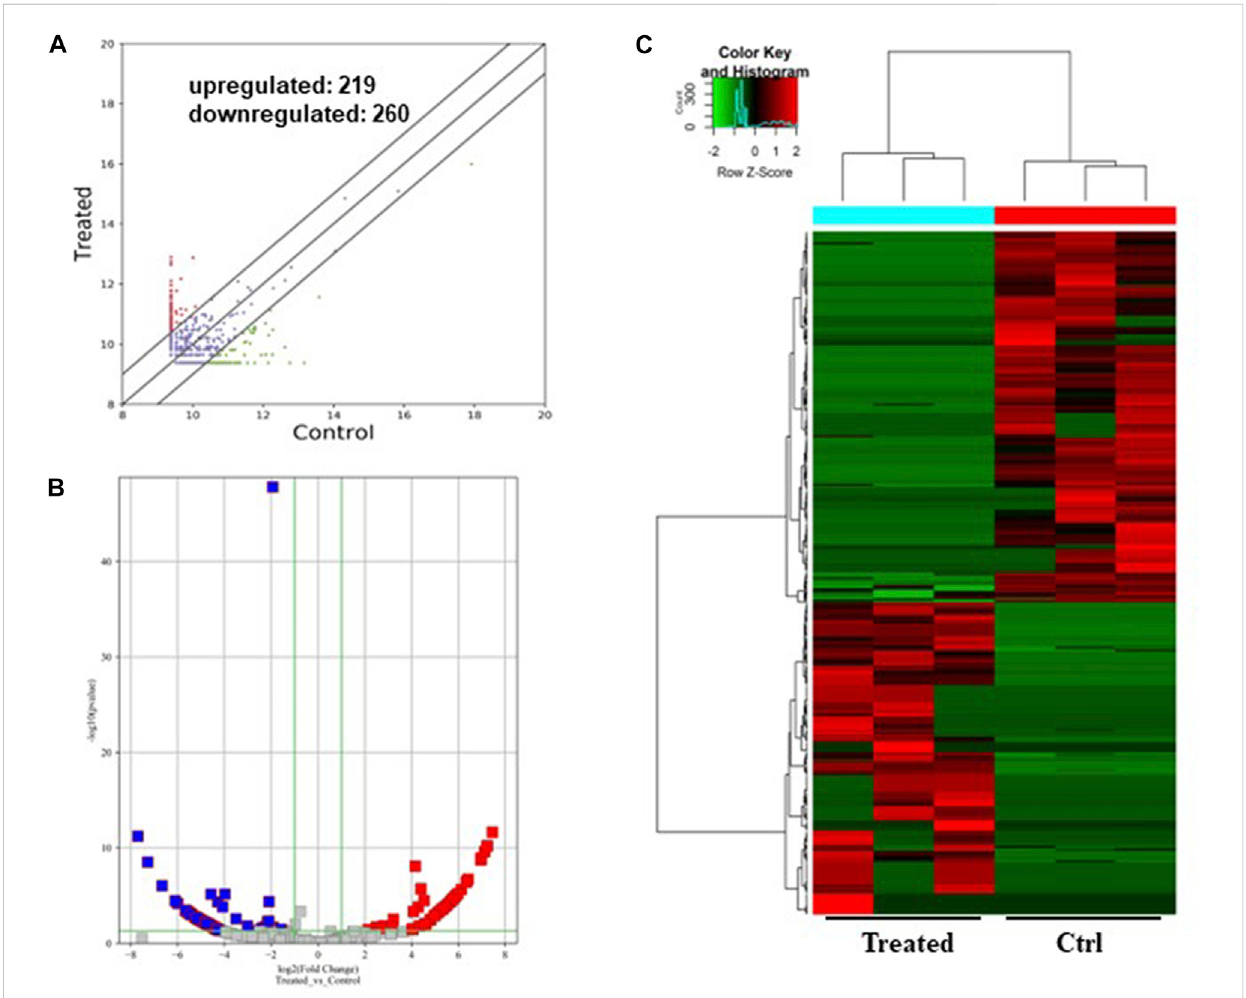
FIGURE 3 Differentially expressed circRNAs in the GO-AgNPs treated caprine fetal fi broblast cells. (A) Hierarchical cluster analysis of circRNAs in the cells between treated and control group. The values of the x and y-axes in the scatterplot are the averaged normalized signal values of groups of samples (log2 scaled). The oblique lines are fold change lines. The circRNAs with the red points (219) and blue points (260) indicate > 2.0 fold changes between control and treated cells. (B) . Volcano plots were constructed using fold-change values and p -values. The red and blue points represent the differentially up- and downregulated circRNAs with statistical signi fi cance (fold-changes of > 2 and p values of < 0.05). (C) Clustered heatmap of differentially expressed circRNAs in the cells. The red and green represent upregulated and downregulated circRNAs,